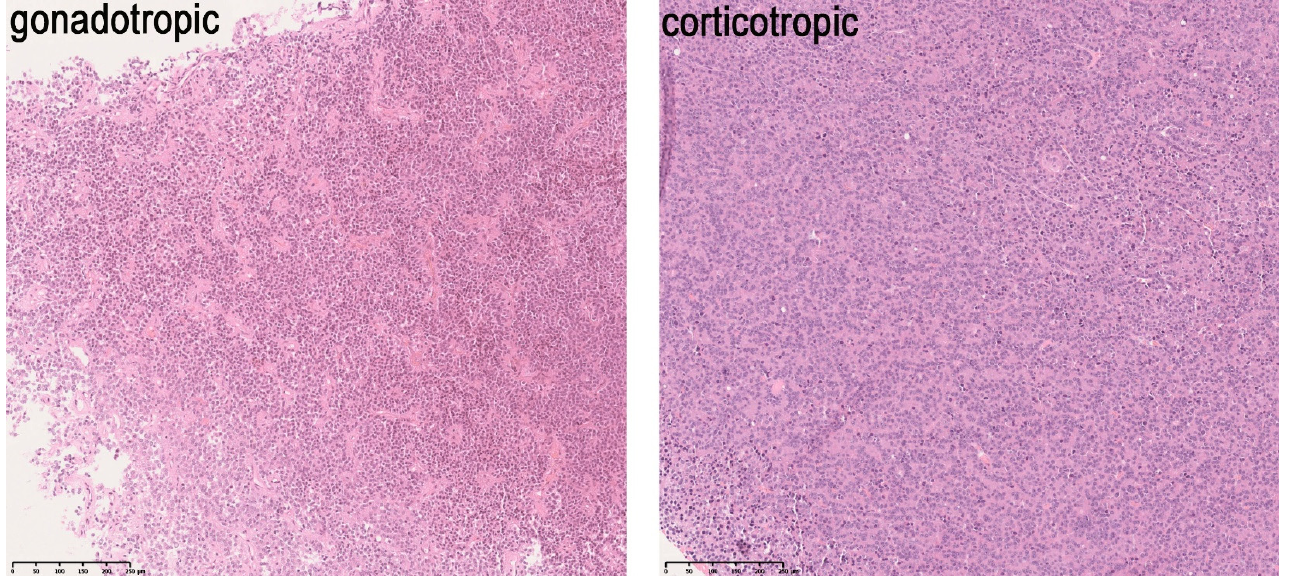
Figure 2. Histopathologic findings in gonadotropic ( left part) and corticotropic ( right part) pituitary gland adenoma. A typical pattern in gonadotropic adenoma is the pseudo sinusoidal growth pattern.